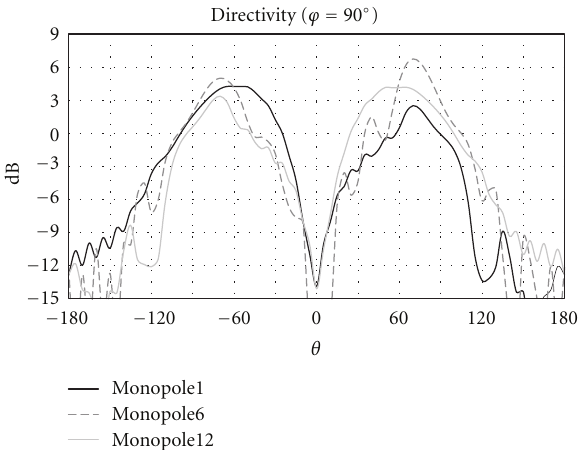
Figure 3: Radiation patterns of monopoles when the monopoles are successively fed.